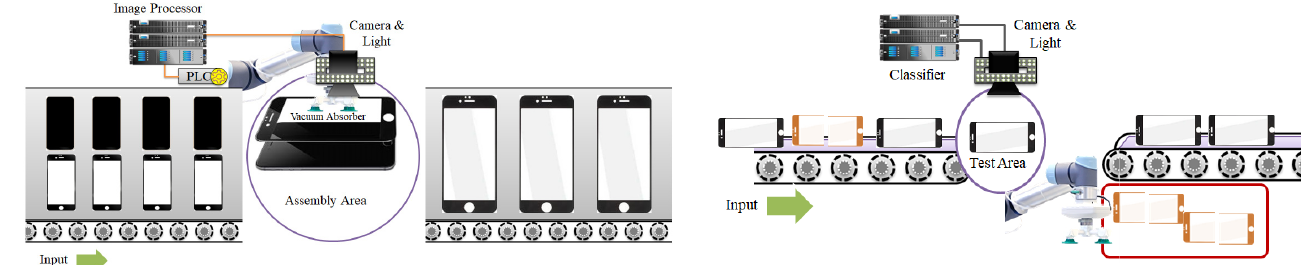
Figure 1. Product assembly process ( left ) and inspection process ( right ).